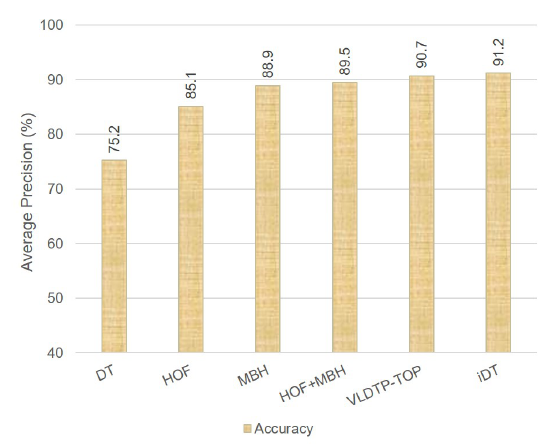
Figure 18. Comparison between the proposed approach and the extant approaches for the UCF50 dataset.